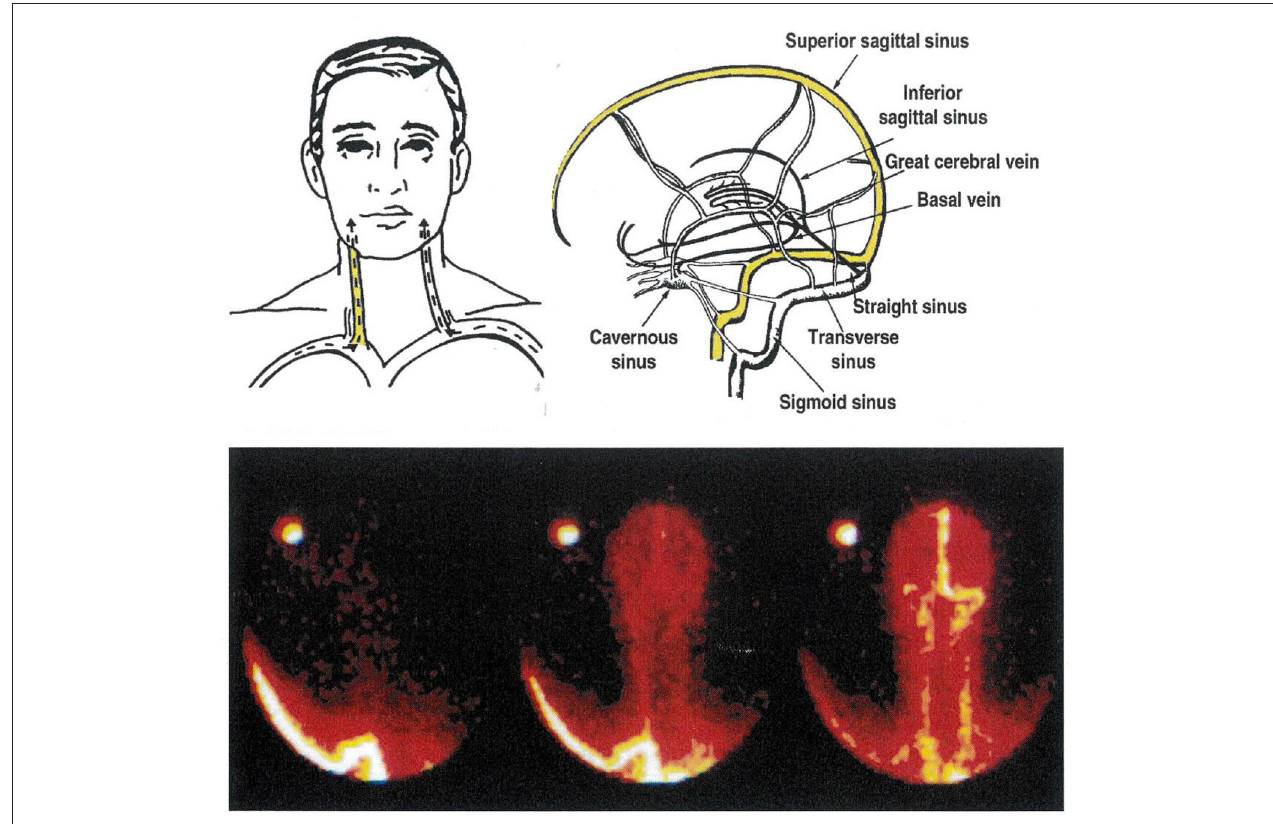
FIGURE 2 | The cerebral venous sinuses of the brain. The lower panel is of a Technetium-99 scan of the sinuses, recorded from behind. In this patient, the sagittal sinus drains to the right, into the transverse sinus and the right internal jugular vein. The straight sinus, with flow from the hypothalamus and amydala in particular, drains into the left internal jugular vein. This is the commonest anatomical pattern, but is reversed in some people. Knowledge of the pattern of brain venous drainage in individual patients, with bilateral internal jugular vein sampling, allows selective quantification of monoamine turnover in cortical, and in suprabulbar subcortical brain regions. The brainstem drains into the spinal